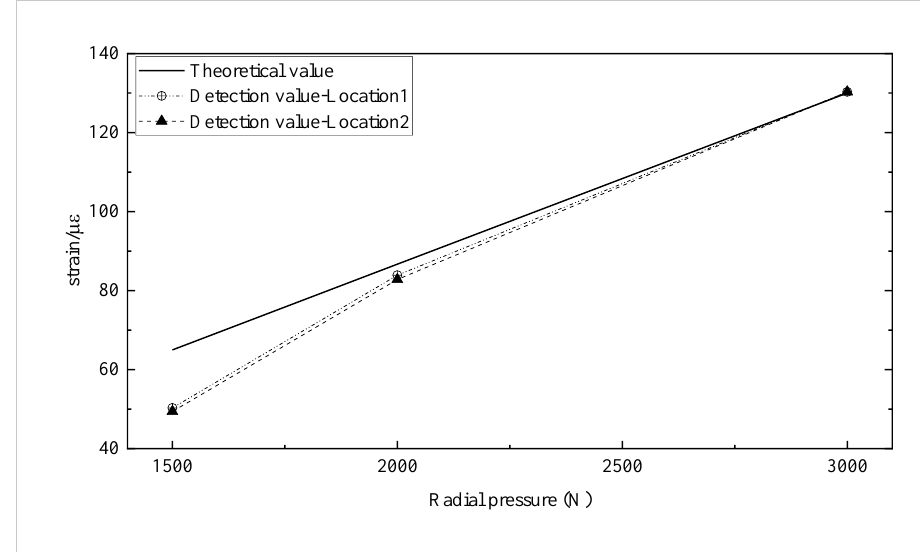
Figure 7. Theoretical and detection values of applied stress strain at each radial